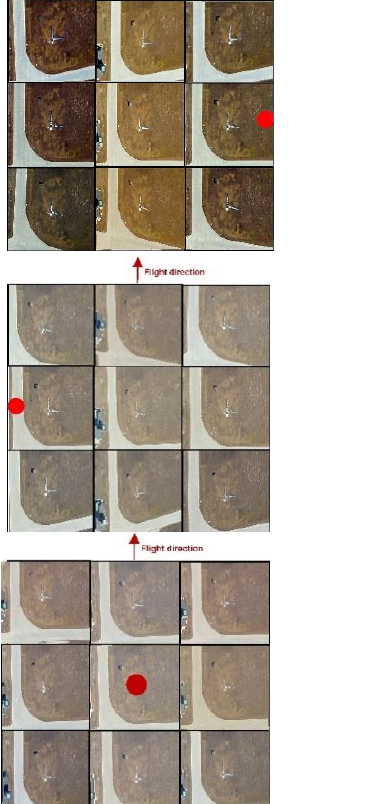
Figure 8. Right RGB camera - left looking /Nadir RGB cam- era/Left RGB camera - right looking